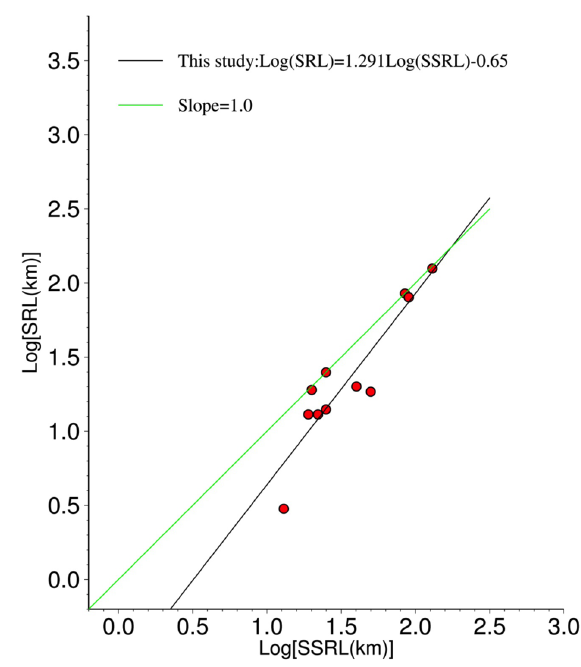
for 11 Iranian earth- Figure 11. Diagram of SRL versus SSRL estimated from the distribu- W tion of source parameters for 11 continental earthquakes in